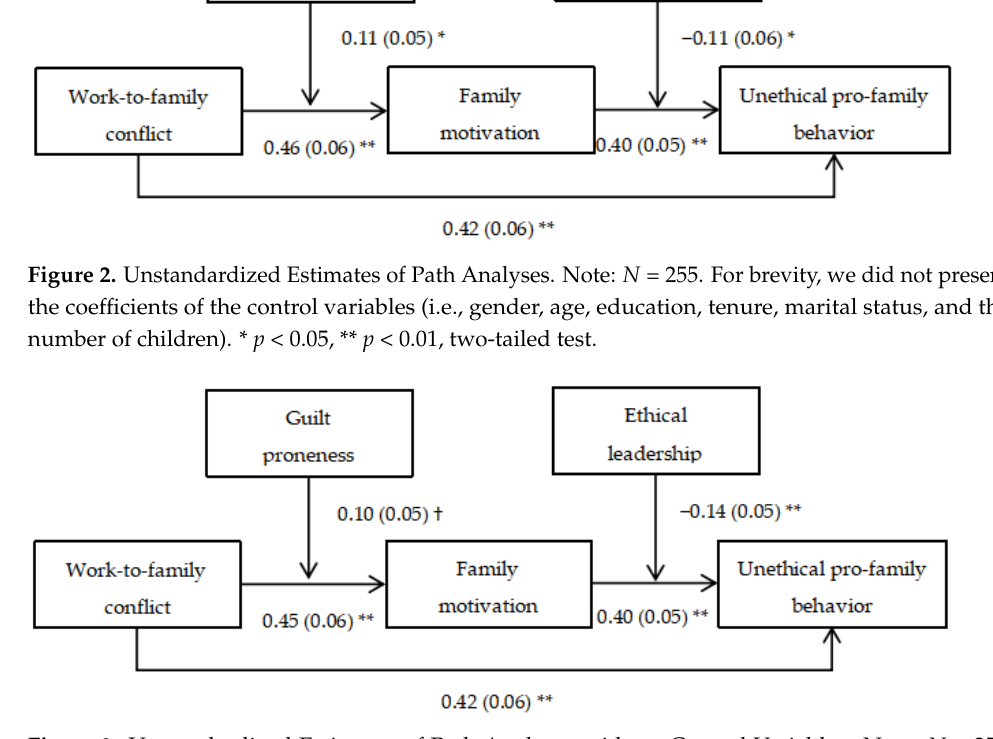
Figure 3. Unstandardized Estimates of Path Analyses without Control Variables. Note: N = 255. † = 0.0056.** p < 0.01, two-tailed test.